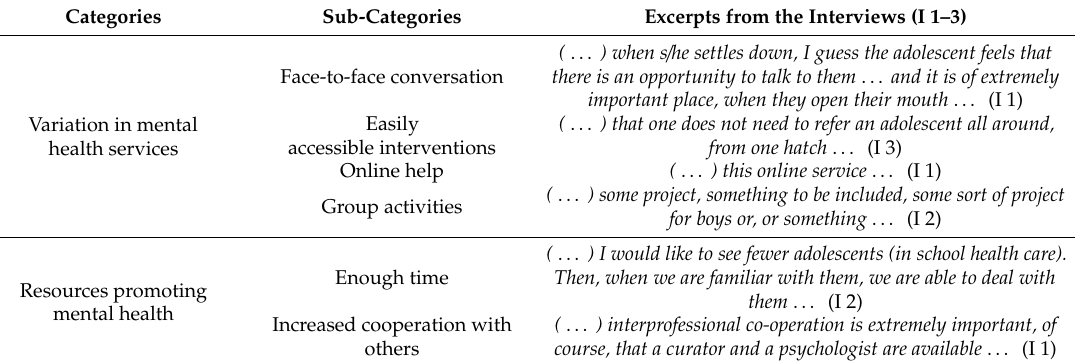
Table 3. School nurses’ developmental suggestions for future promotion of adolescents’ mental health at